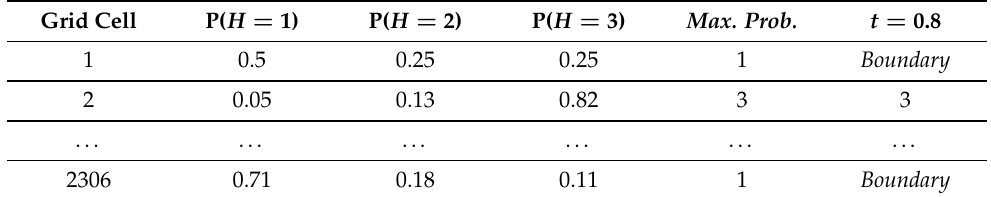
Table 1. An example of the results obtained from the model, in which the probability of belonging to each of three sectors (P( H = h ), with h = 1,2,3) is presented. Max. Prob. refers to a classification based on the highest probability value. In contrast, the last column shows the probability threshold method for t =